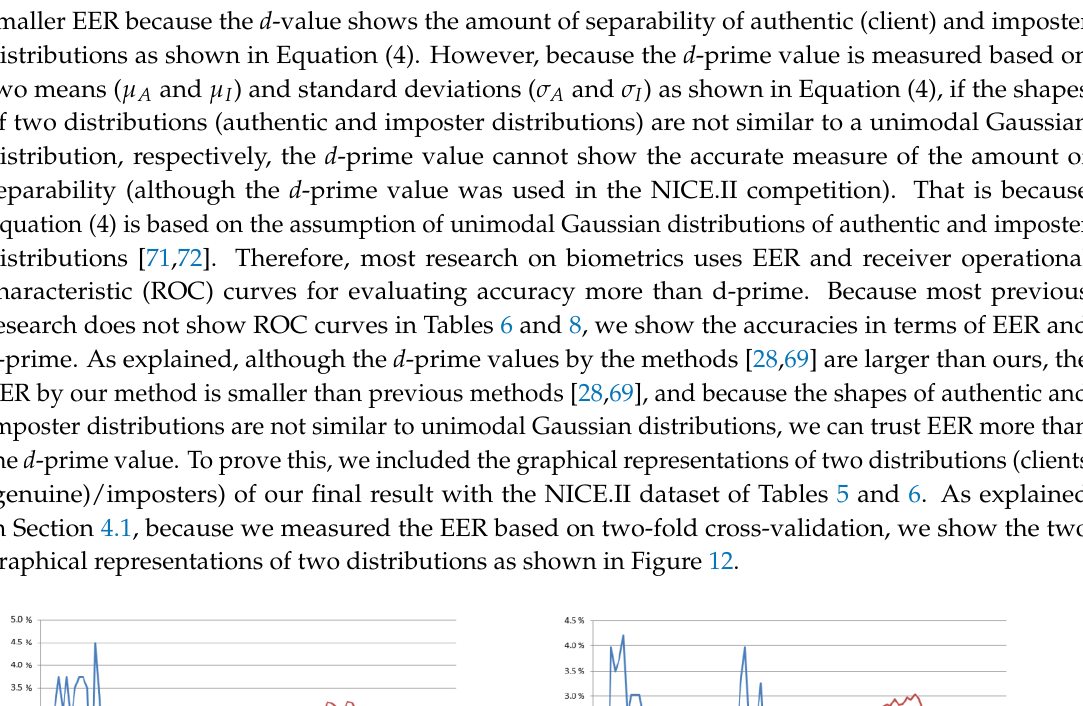
( b ) Figure 13. Graphical representations of clients (genuine) and imposters with testing data of the MICHE dataset. ( a ) First fold cross-validation; ( b ) second fold cross-validation. In ( a ) and ( b ), the left-upper, right-upper and center-lower figures respectively show the representations with the sub-datasets of Galaxy S4, Galaxy Tab2 and iPhone5. As shown in Figures 12 and 13, we can find that the shapes of all the representations of two distributions (clients (genuine) and imposters) are not similar to unimodal Gaussian distributions.